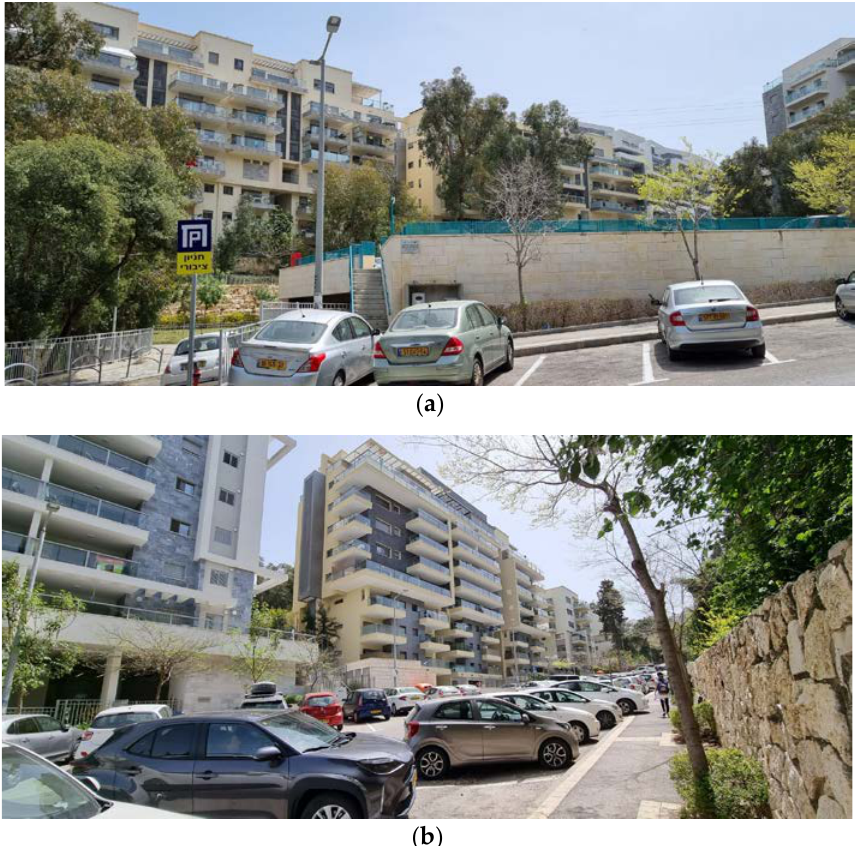
Figure 5. Haviva-Reich site, A view from the inner side of the site ( a ); A view from the entrance to the site ( b ). Photographed by the author, 2022.